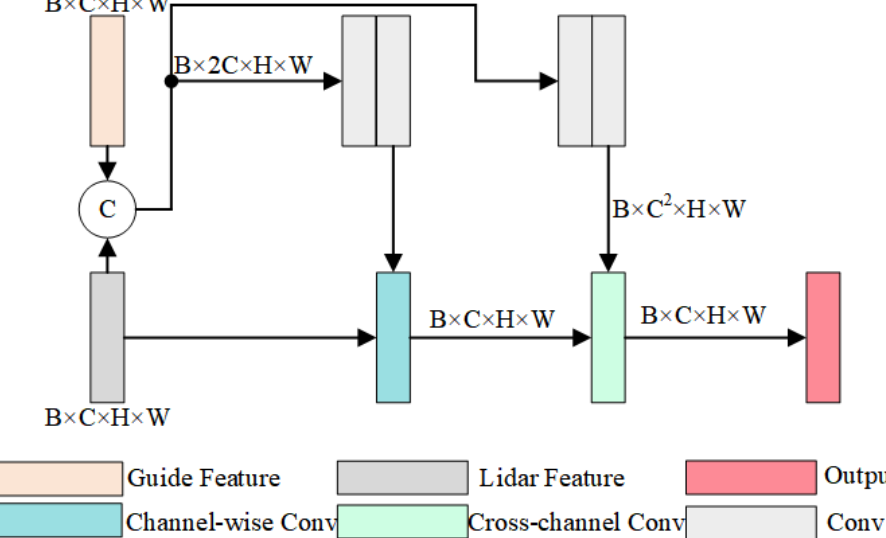
Figure 4. Structural diagram of the lightweight guidance module. It guides features to LiDAR features faster and more efficiently by sharing filtering